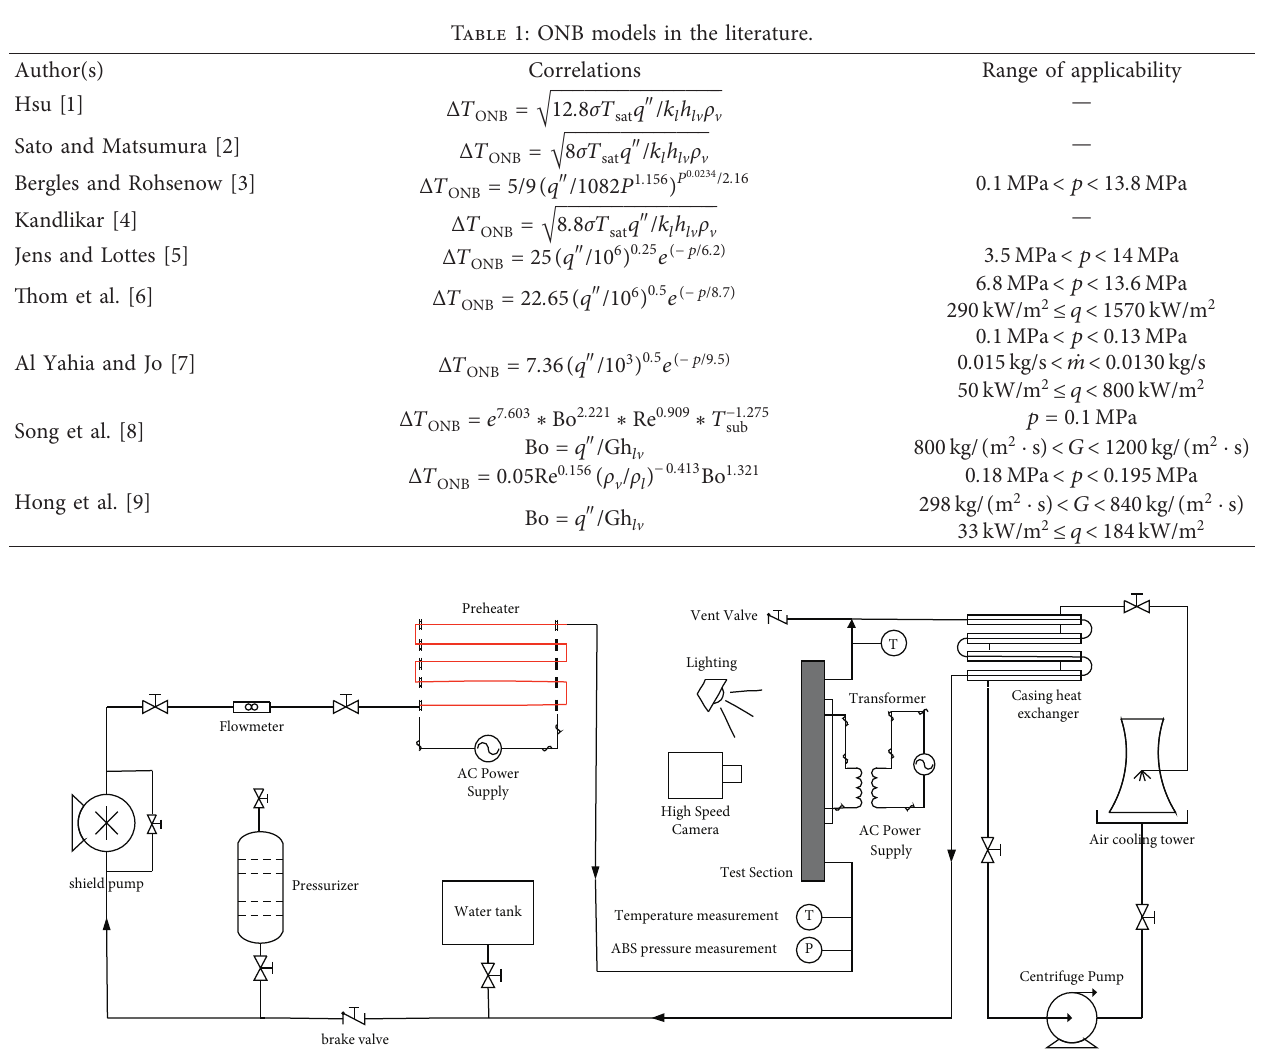
Figure 1: Schematic diagram of the experimental